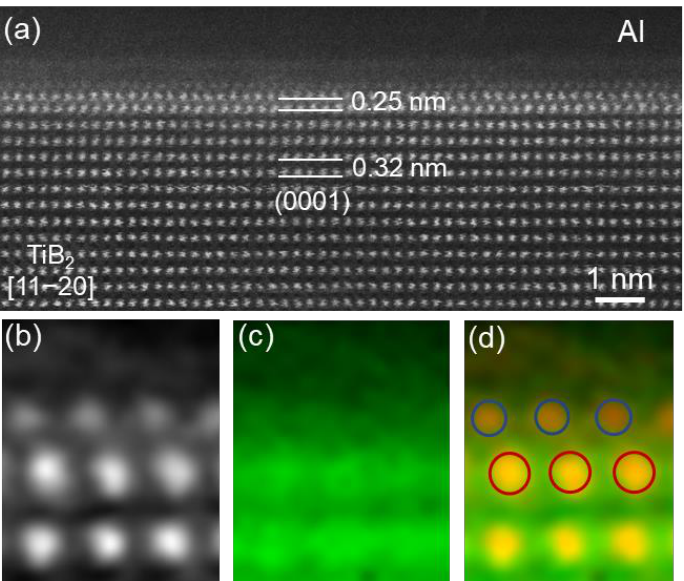
Figure 6. Segregation of Ti at Al/TiB 2 interface [11]. ( a ) Z-contrast STEM-HAADF image; ( b ) local Z-contrast HAADF image across the Al/TiB 2 interface; ( c ) atomic resolution EELS map of Ti K-edge; and ( d ) superimposition of the local image and Ti K-edge map. The atomic columns with blue circles are Ti atoms-rich columns, and those with red circles are Ti columns of TiB 2 . The atomic resolution EELS mapping confirms that the atomic monolayer at the interface contains Ti atoms.